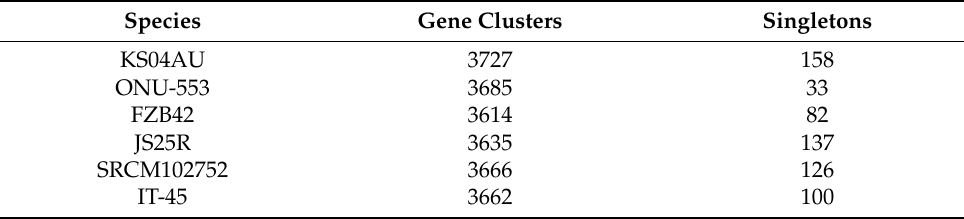
Figure 8. Genomic analysis using Orthovenn2. Venn diagram ( A ) displays the distribution of shared orthologous clusters among B. velezensis and amyloliquefaciens strains. ( B ) The occurrence table shows the occurrence pattern of shared orthologous groups among selected strains. ( C ) Pairwise heatmap of overlapping cluster numbers of compared genomes. Each cell shows the overlap cluster between species. The overlapping cluster numbers refer to the number of gene clusters shared among B. velezensis and amyloliquefaciens strains. Table 10. Comparative analysis of gene clusters using OrthoVenn2.